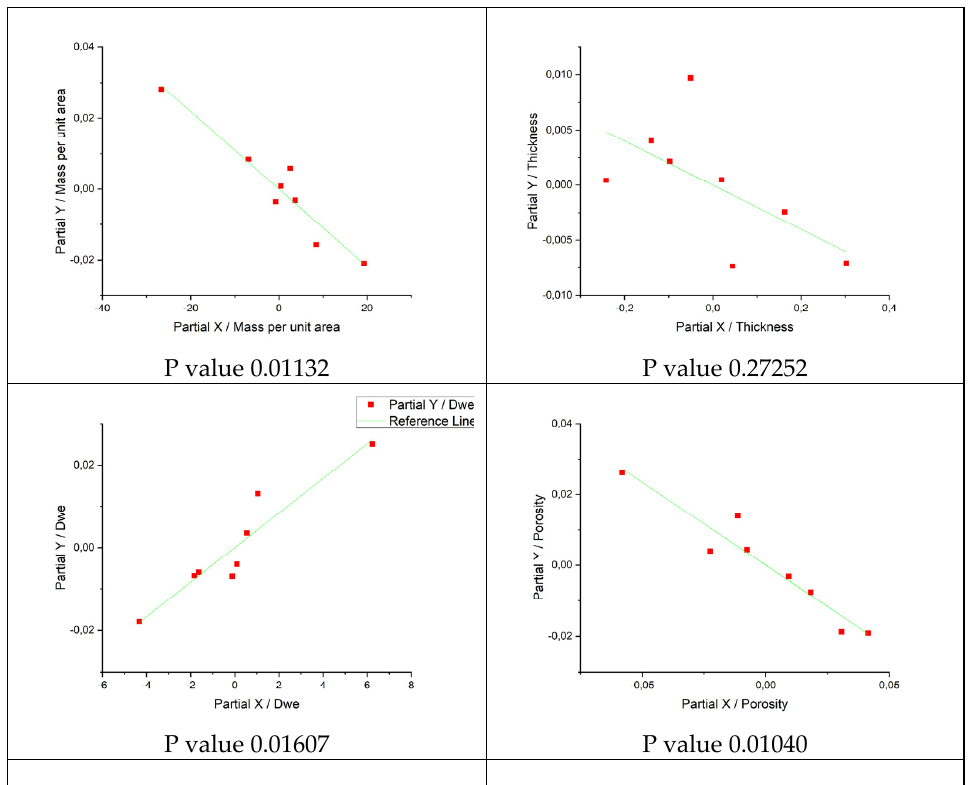
Figure 7. Statistics—multiple linear regression.